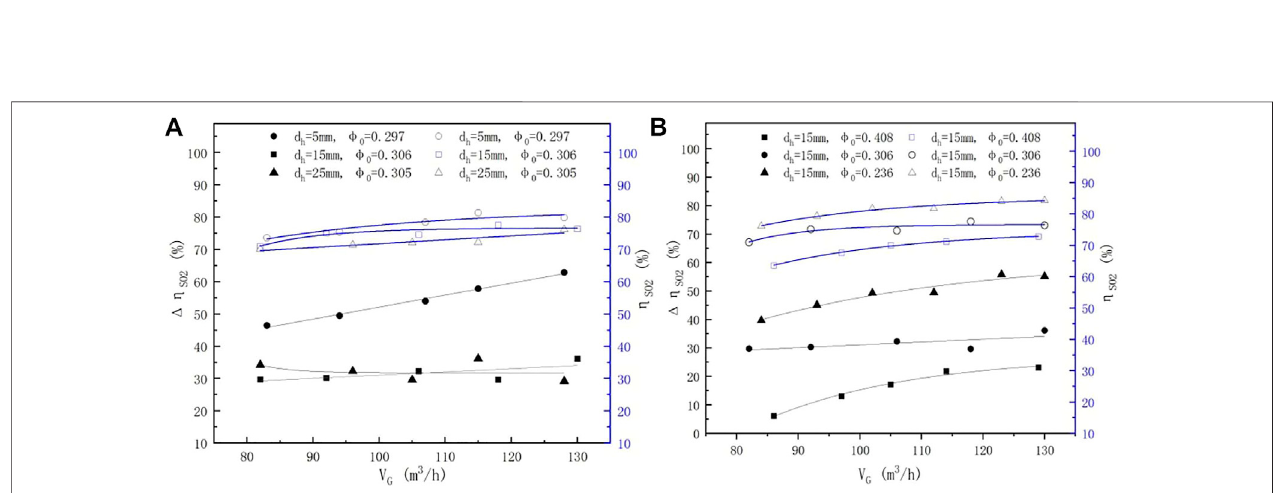
FIGURE 5 | Δη SO2 and η SO2 under different slurry fl ow rates (C SO2 = 700 ± 50 mg/m 3 , V G = 105 m 3 /h, and pH = 6), (A) pore diameter, and (B) porosity.